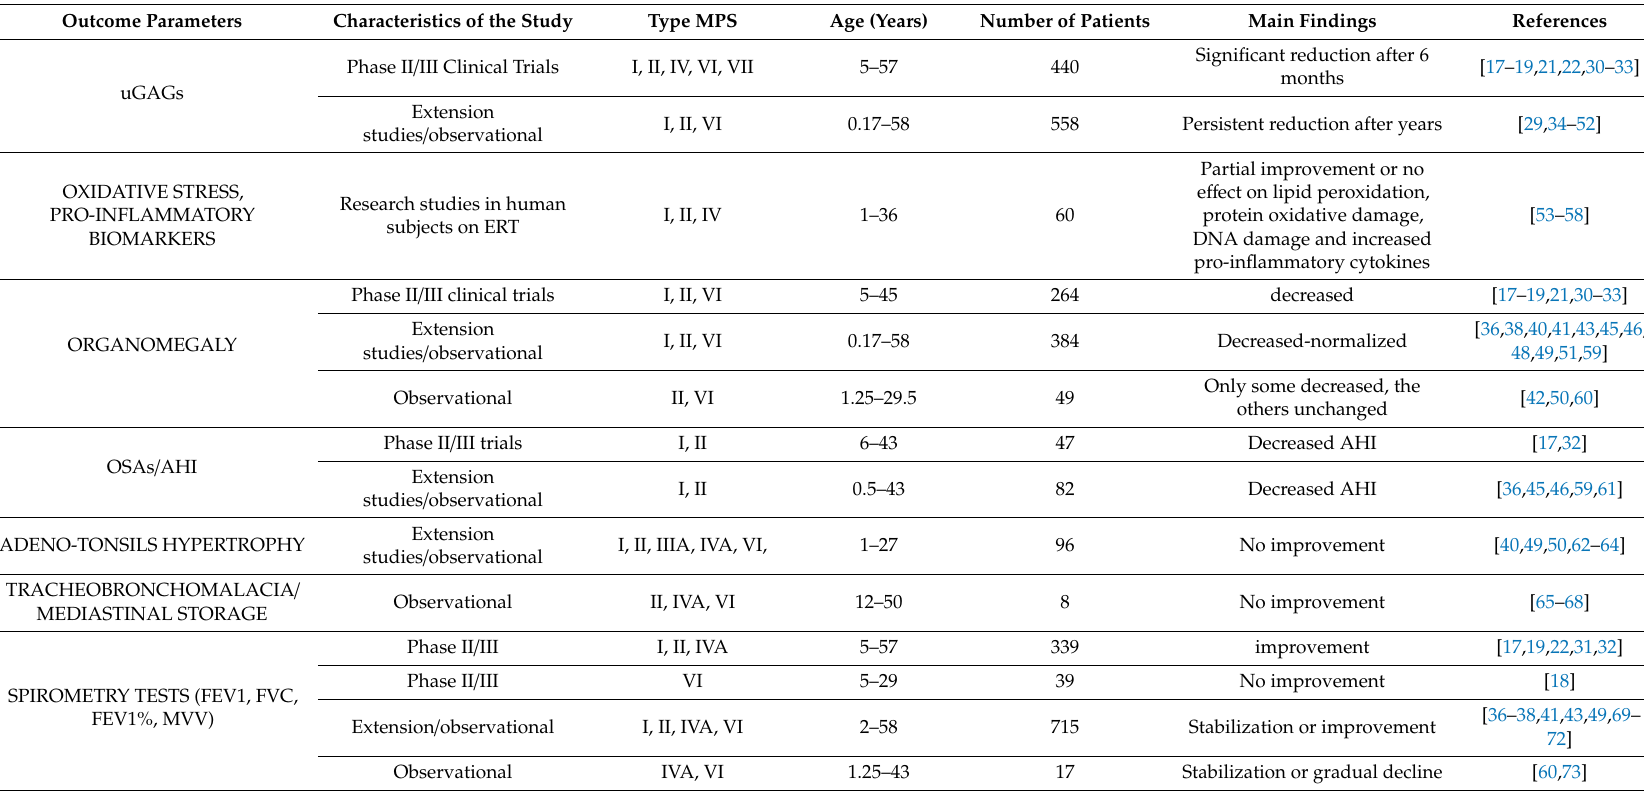
Table 2. Summary of results by outcome parameters in clinical trials and post-marketing studies of enzyme replacement therapy (ERT) in MPSs. The main findings of outcome parameters are reported summarizing data of all types of MPSs